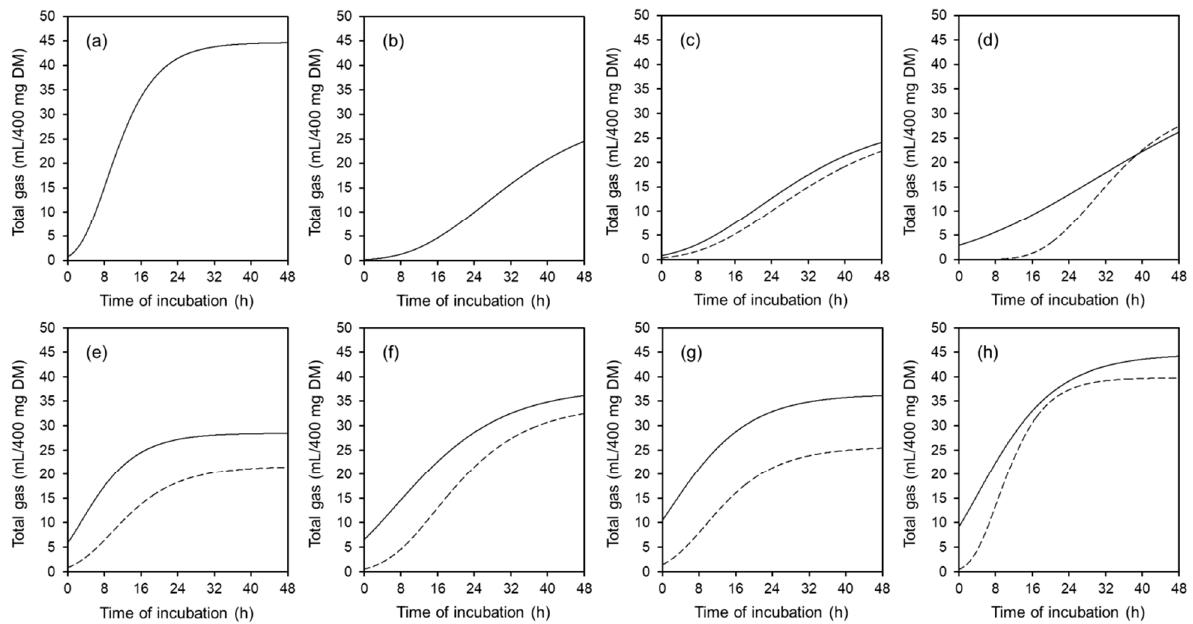
Figure 1. Cumulative gas production of starch ( a ), purified cellulose ( b ), powdered cellulose ( c ), mycelium of Aspergillus niger ( d ), lucerne chaff ( e ), soybean shells ( f ), wheat bran ( g ), and sugar beet pulp ( h ), with pre-digestion (dashed line) and without pre-digestion (solid line), modeled by Gompertz non-linear regression function. DM: dry matter.